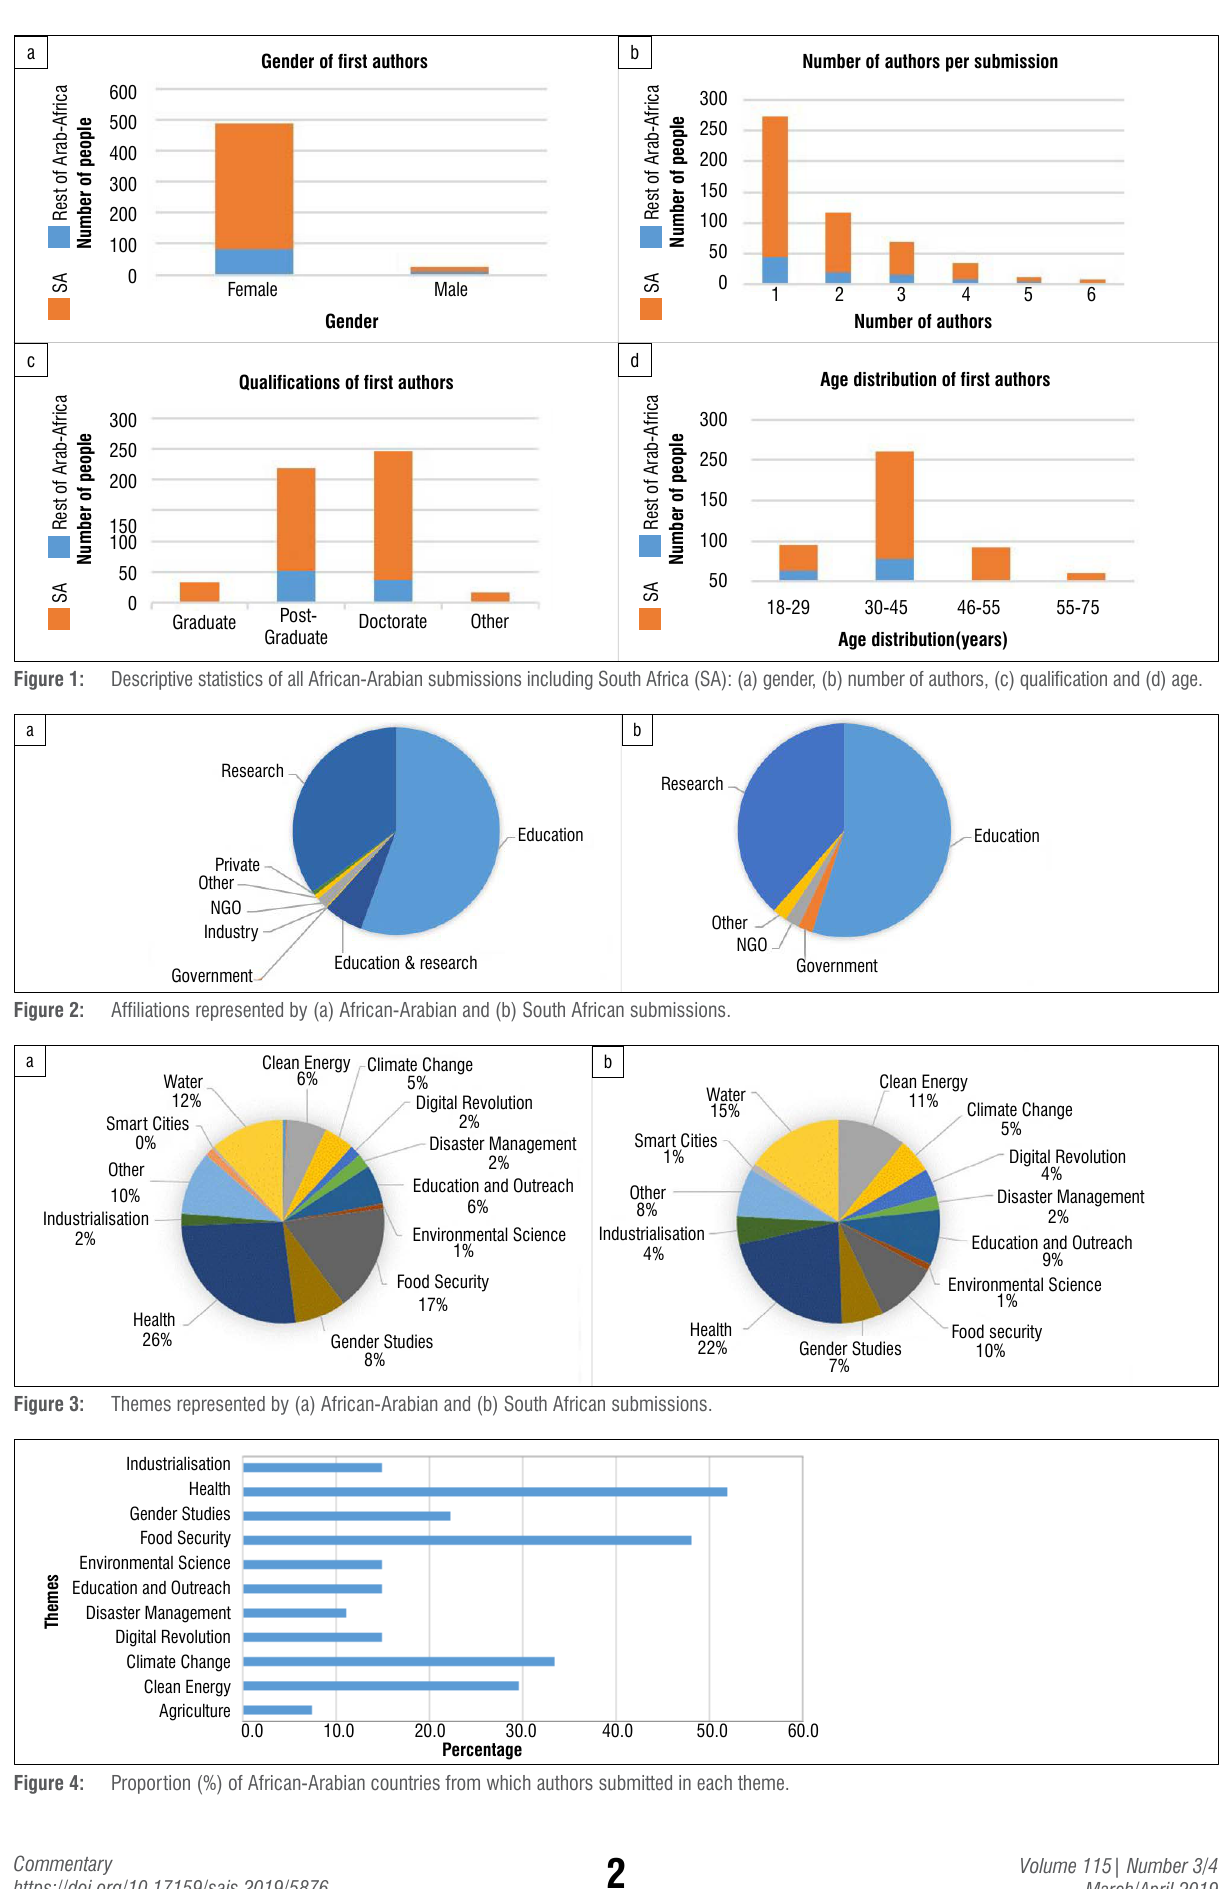
March/April 2019